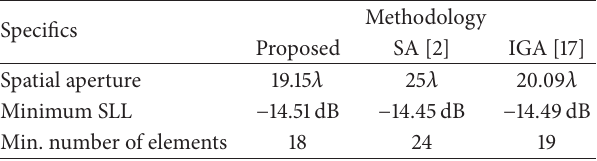
Table 4: Comparison between method [2], method [17], and proposed iterative GA methods with regard to minimum array elements and minimized SLL.